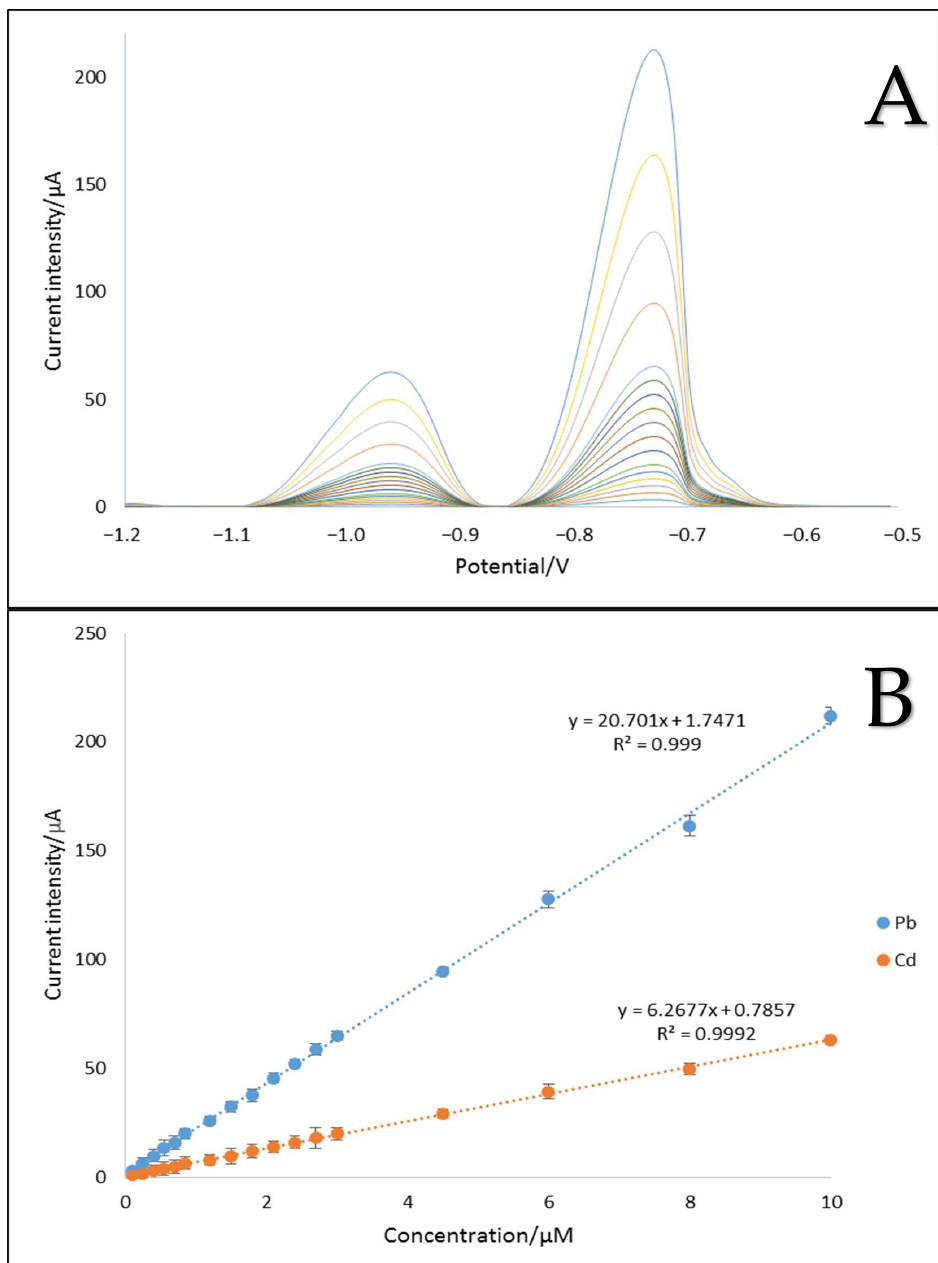
Figure 7. Differential pulse anodic stripping voltammograms ( A ) obtained upon increasing metal ions concentration in 1 mol L –1 acetate buffer solution (pH 4), following deposition at −1.2 V for 90 s and corresponding calibration curves ( B ) in the linear range from 0.1 to 10 µmol L –1 . The obtained recoveries were in the range from 96.4% to 101.6%, indicating that